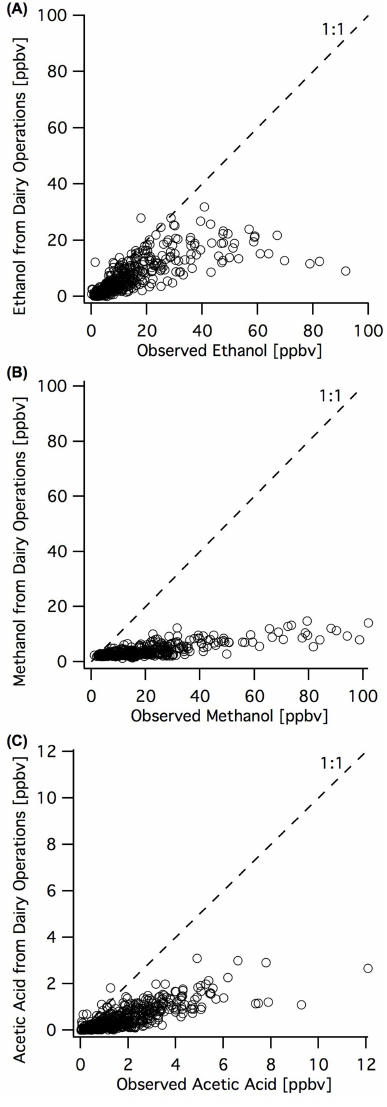
Figure 9. Estimated concentrations of non-methane organic com- pounds emitted by dairy operations shown against ambient obser- vations at the Bakersfield ground site. Emissions are apportioned to dairy operations using the emission ratios of methane determined using aircraft and ground site measurements. On average, 45% of observed (A) ethanol is from dairies, whereas, smaller fractions of (B) methanol (27%) and (C) acetic acid (28%) are from dairy op- erations. These fractions vary with time of day and source strength. Diurnal patterns of percent contributions from dairy operations are shown in Supplement Fig.